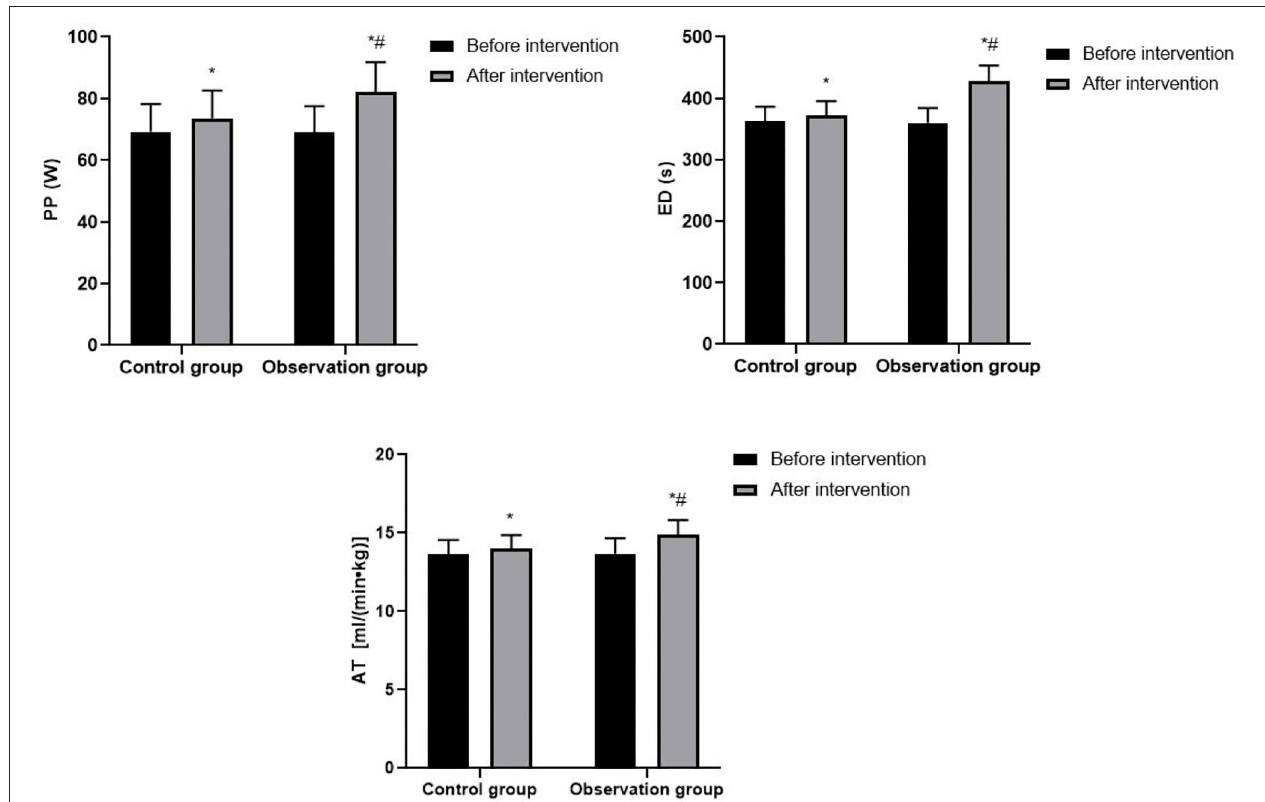
FIGURE 2 | Exercise endurance of patients. Compared with before intervention, * P < 0.05; compared with control group, # P < 0.05.